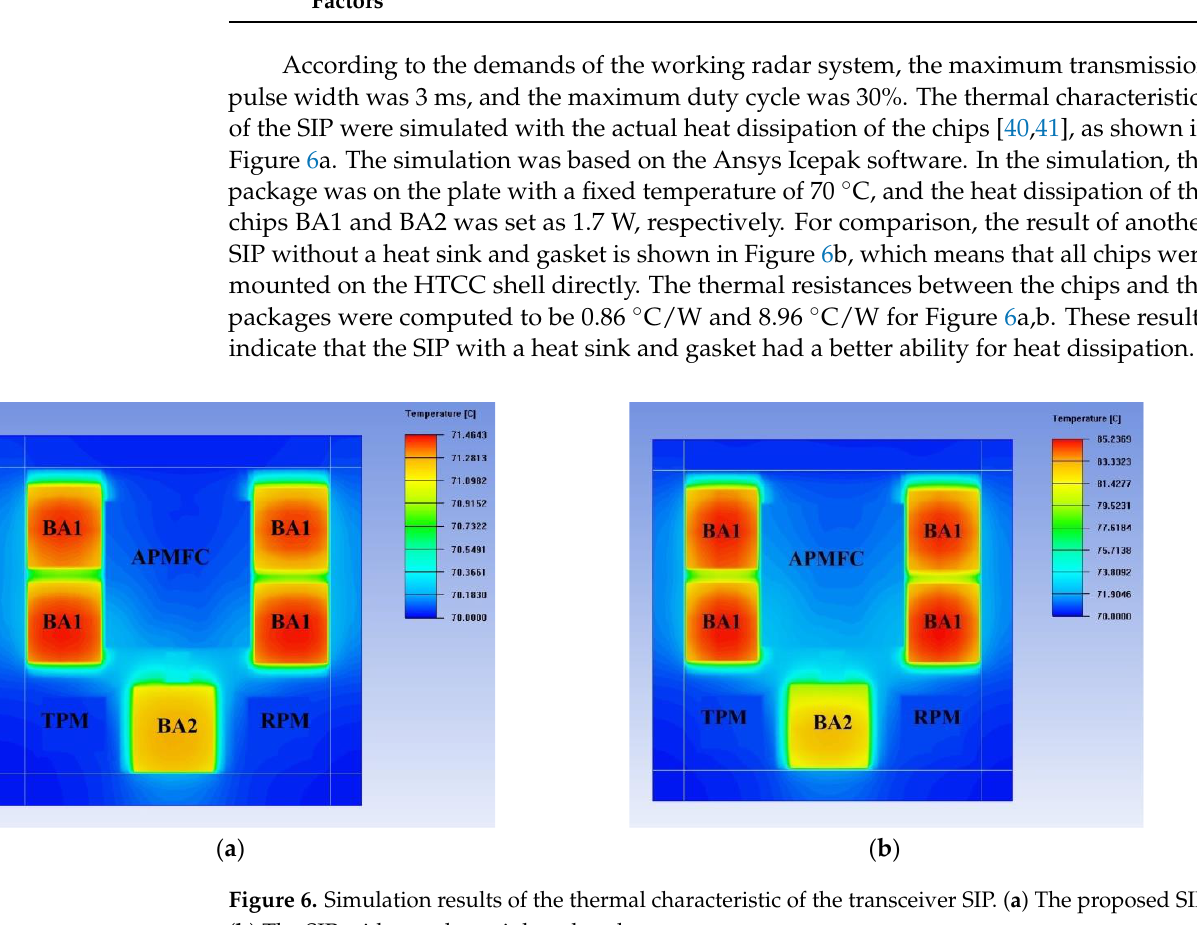
Figure 7. Internal photograph of the proposed transceiver SIP. The test fixture of the Ku-band four-channel transceiver SIP is shown in Figure 8. The SIP was mounted on the multi-layer microwave printed circuit board (PCB) by welding. External cables connected the power and control terminal to the test instrument. After the top metal lid was sealed by parallel sealing technology, the measurement shows that the air-tightness rate of this module was 9 × 10 -10 Pa·m 3 /s.